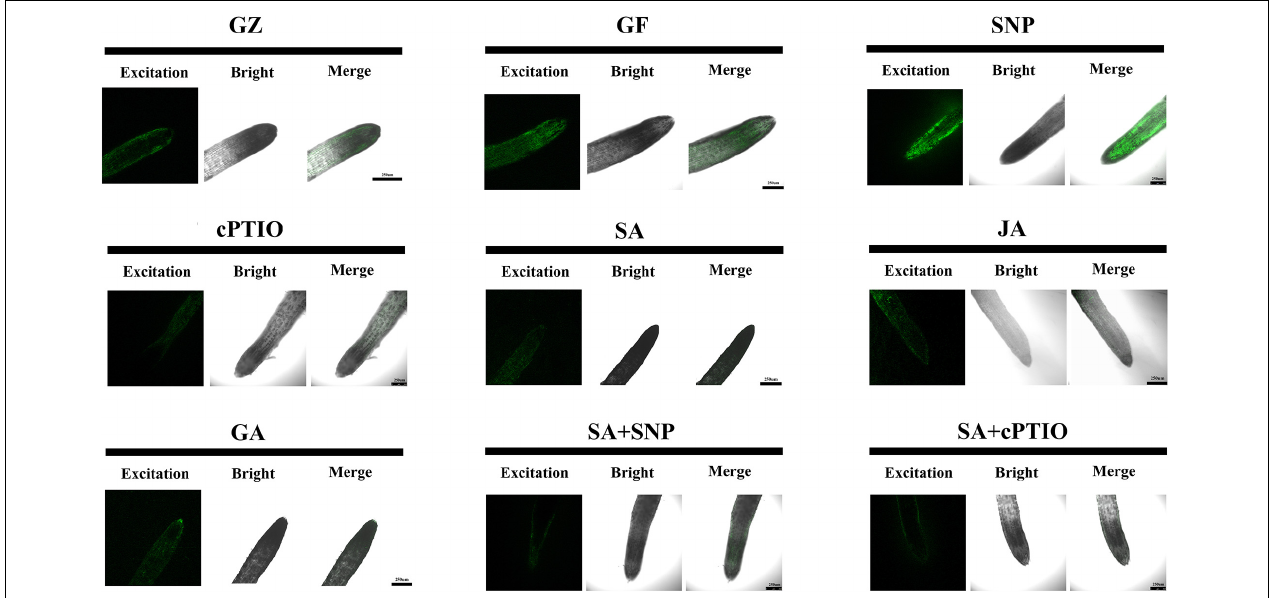
FIGURE 11 | Nitric oxide (NO) accumulation in roots of T. hemsleyanum after the respective treatment of NO effectors and/or phytohormones under the photovoltaic condition (GF) and the normal light condition (GZ), using 10 µ M DAF-2DA as a fluorescent probe. The figure is representative of ten segments stained in each